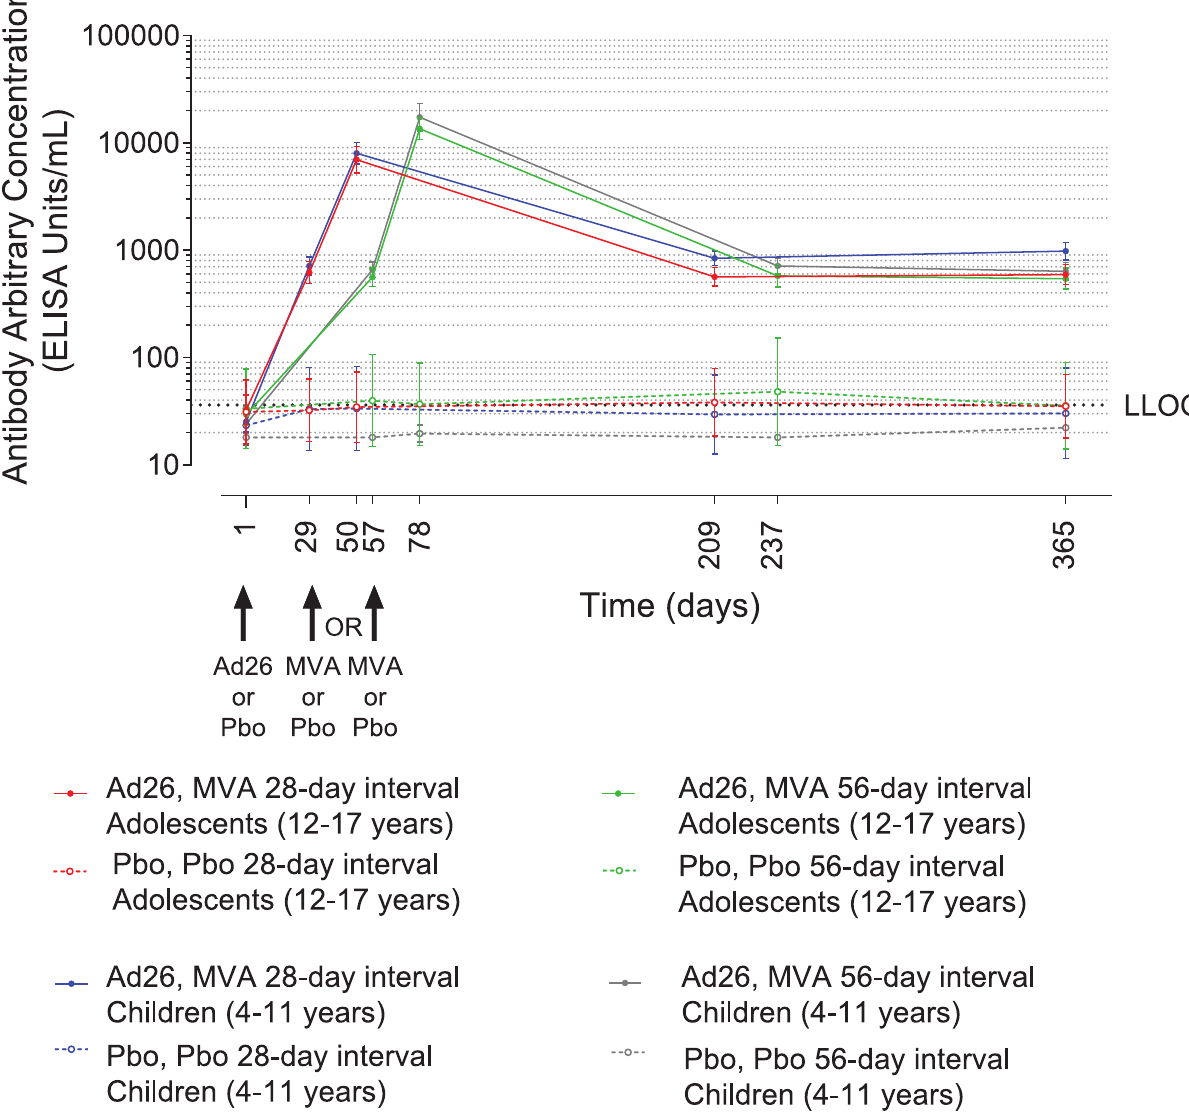
PLOS Medicine| https://doi.org/10.1371/journal.pmed.1003865 January 11,